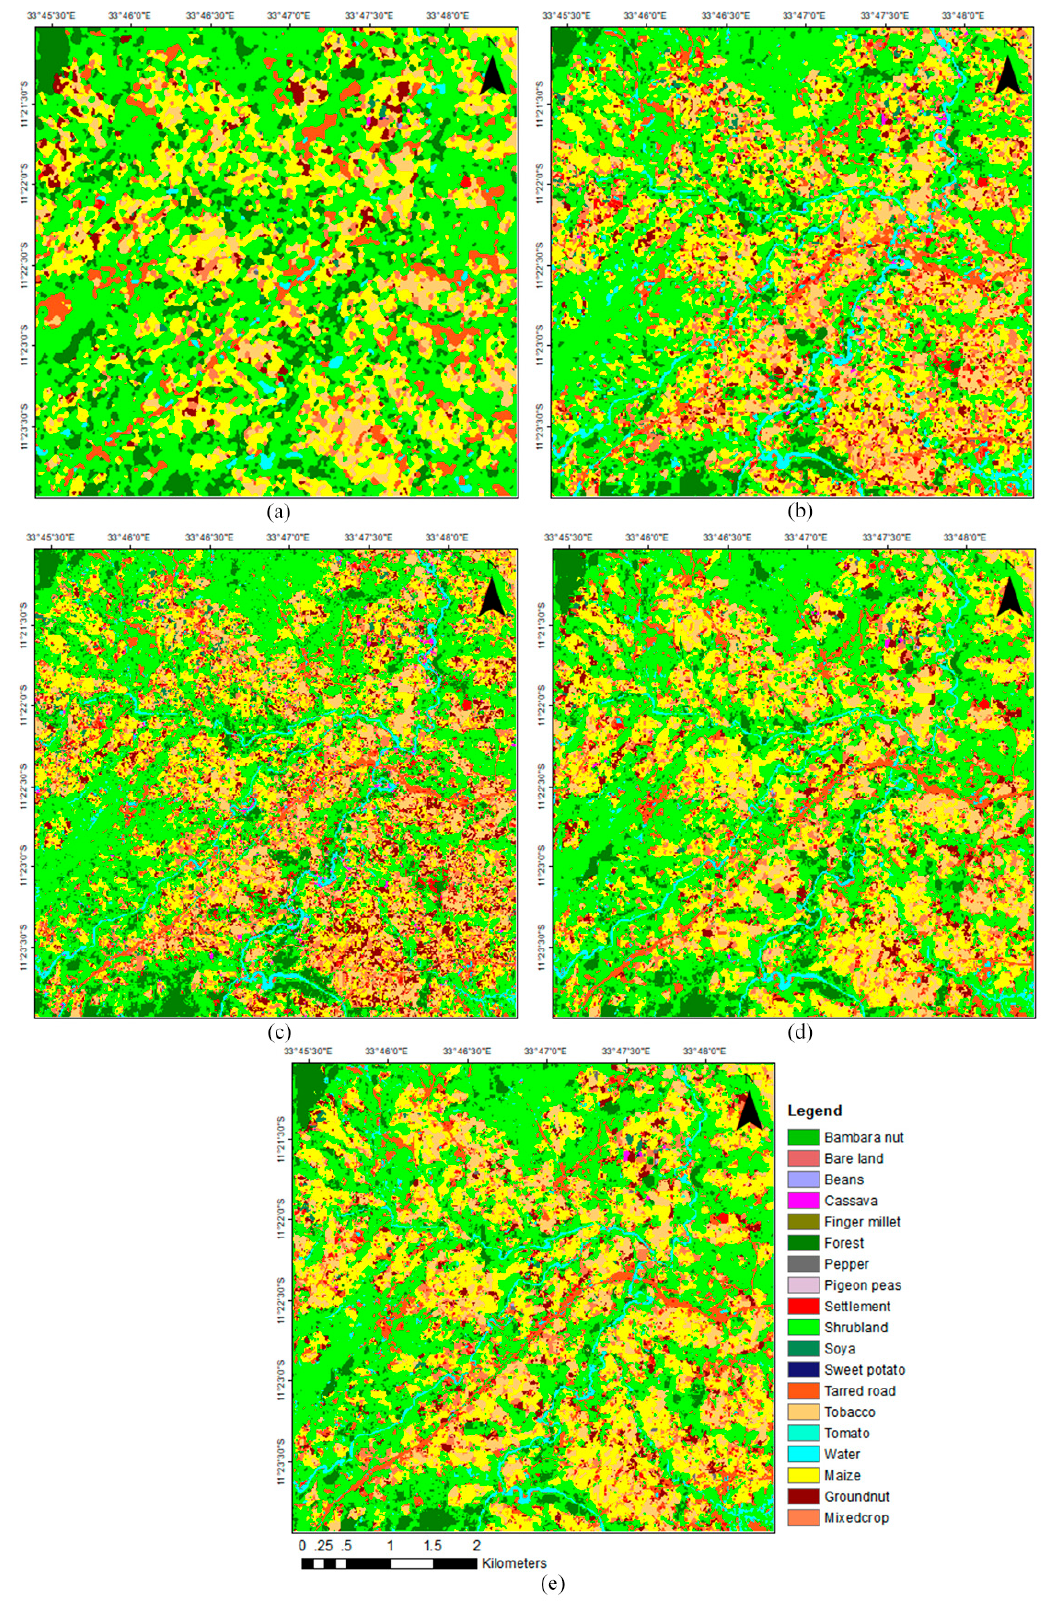
Figure 7. Classification results of Edundu area ( a ) using Sentinel-1 only; ( b ) using Sentinel-2 only; ( c ) using the fused image of Sentinel-2 and PlanetScope; ( d ) using the fused image and Sentinel-1 C 2 matrix; ( e ) using the fused image, Sentinel-1 C 2 matrix, and H/ α polarimetric decomposition.